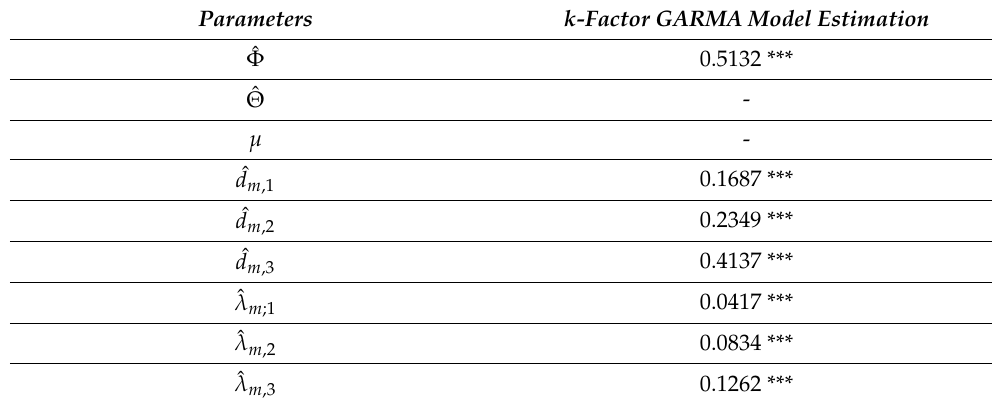
Table 3. Estimation of the k -factor GARMA model: a wavelet-based